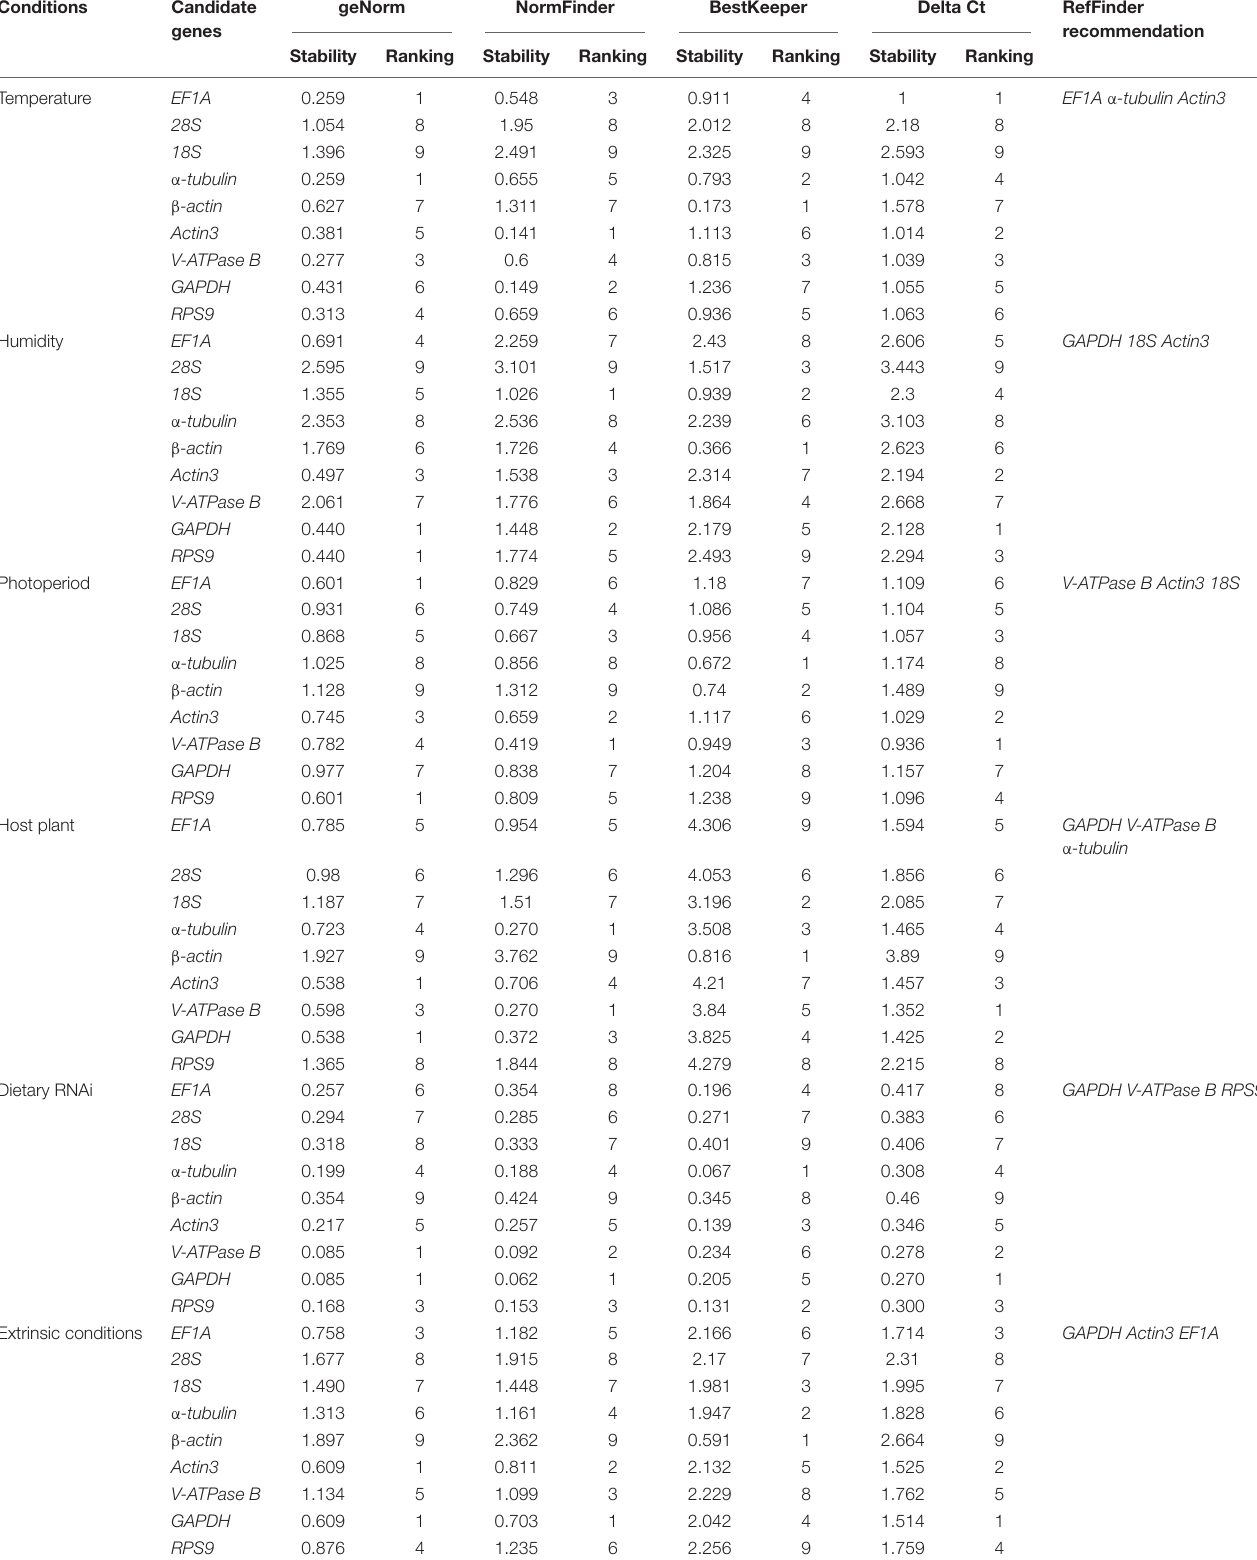
TABLE 2 | Stability of candidate reference genes under different extrinsic